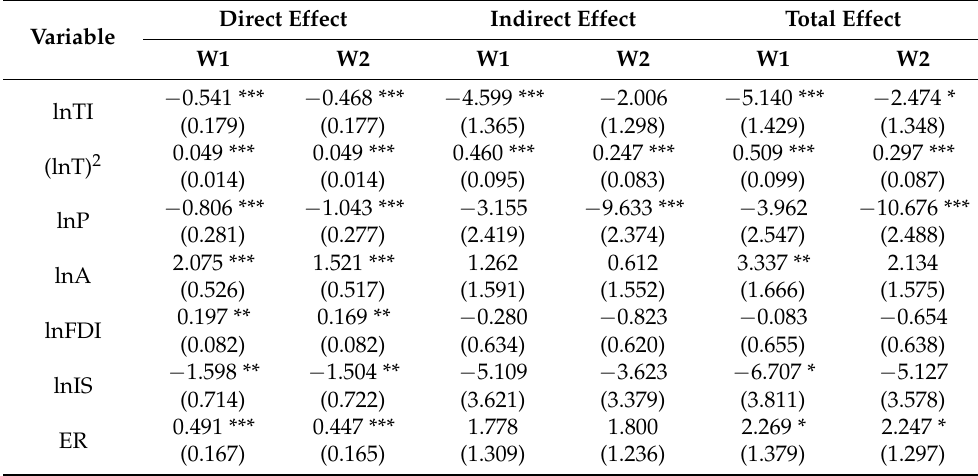
Table 5. The effect decomposition of SPDM.